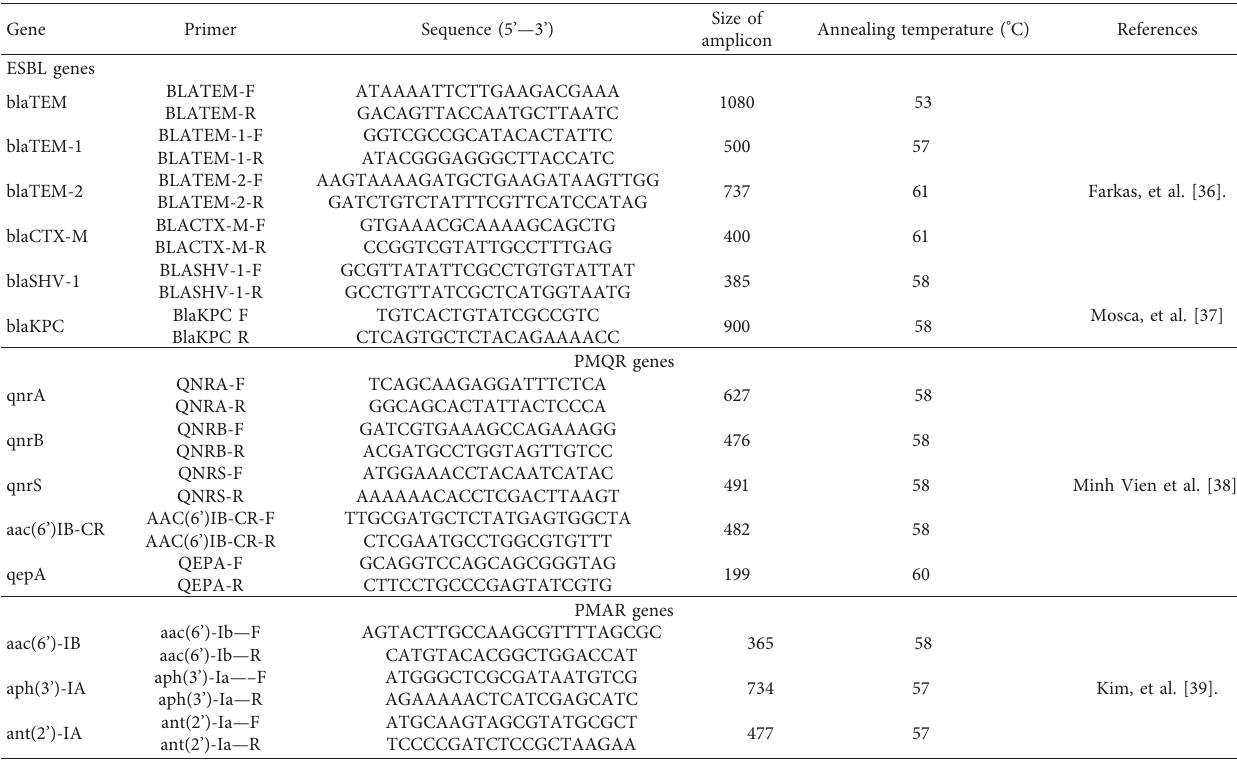
Table 2: Oligonucleotides used.